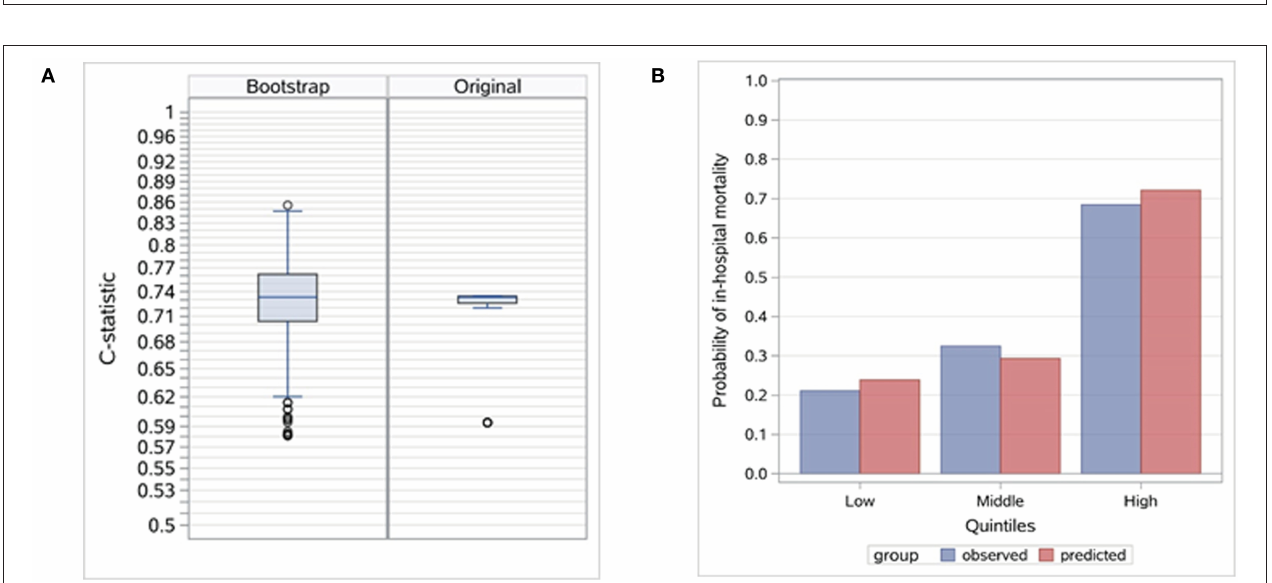
FIGURE 2 | Evaluation of the risk model. (A) Distribution of c-statistic in bootstrap and original samples. Internally validated c-statistic is 0.7308. (B) Distribution of observed in-hospital mortality by stratified predictive probability.